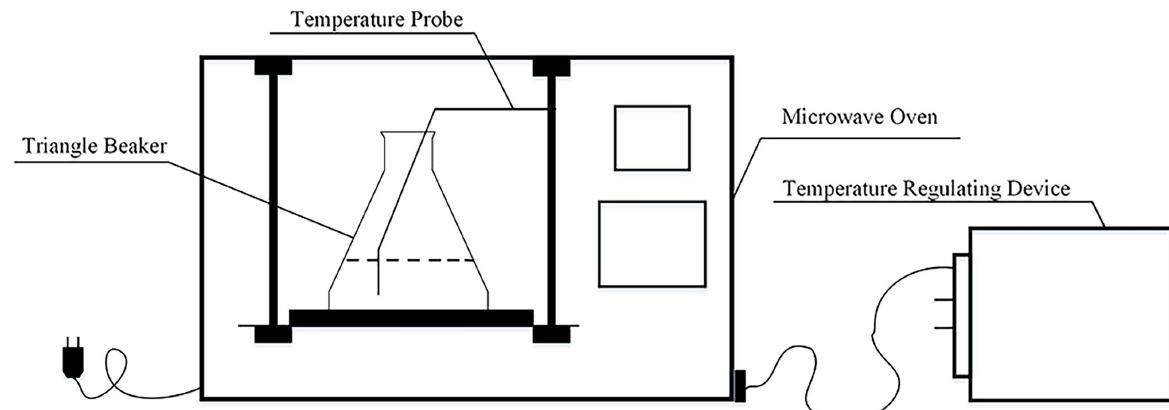
Figure 1. Equipment